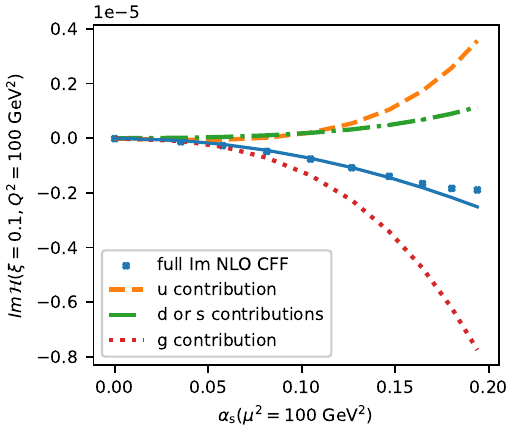
Figure 2: Imaginary part of the NLO CFF H ( ξ = 0.1, Q 2 = 100 GeV 2 ) evaluated with the NLO shadow GPD 1 shown in Fig. 1 and H d (+) = H s (+) = H g (+) = 0 at µ 2 = 1 GeV 2 . The blue dots correspond to computations made with different values 0 ( µ 2 = 100 GeV 2 ) and the solid blue line results from a quadratic fit to the first of α S seven points. The dashed orange, dash-dotted green and dotted brown lines indicate u , d or s , and g contributions to the CFF,